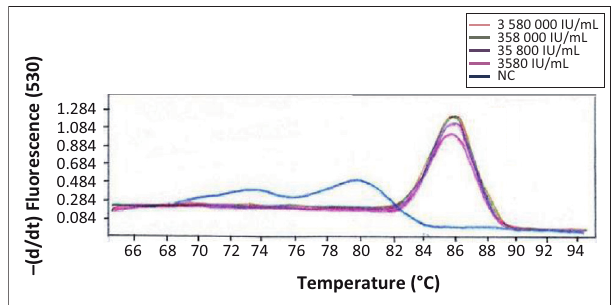
FIGURE 3: Internal quality controls. Internal quality control DBS specimens were prepared by spiking HCV-negative whole blood with HCV-positive plasma. Ten-fold dilutions were prepared with a starting concentration of 3580 000 IU/mL of HCV RNA and added onto Whatman Filter paper. HCV- negative whole blood was used as a negative control. An HCV RNA concentration of 3580 IU/mL was the lowest concentration of RNA detected for DBS using the optimised PCR